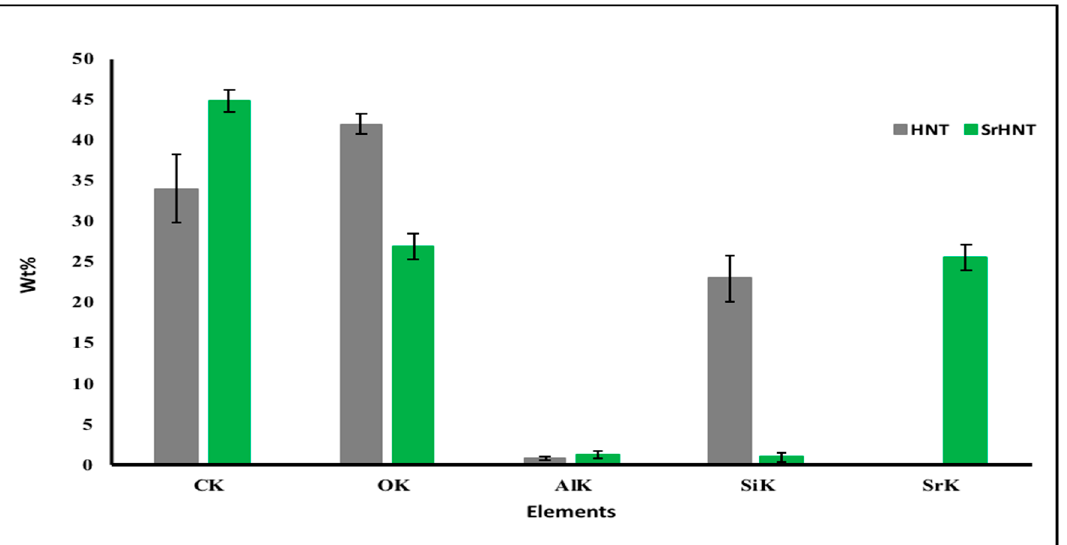
Figure 5. Quantitative wt.% of the elements present in HNT and SrHNT namely K shell of C, Al, Si, O, and Sr where n = 5. The error bars = standard deviation of the samples.